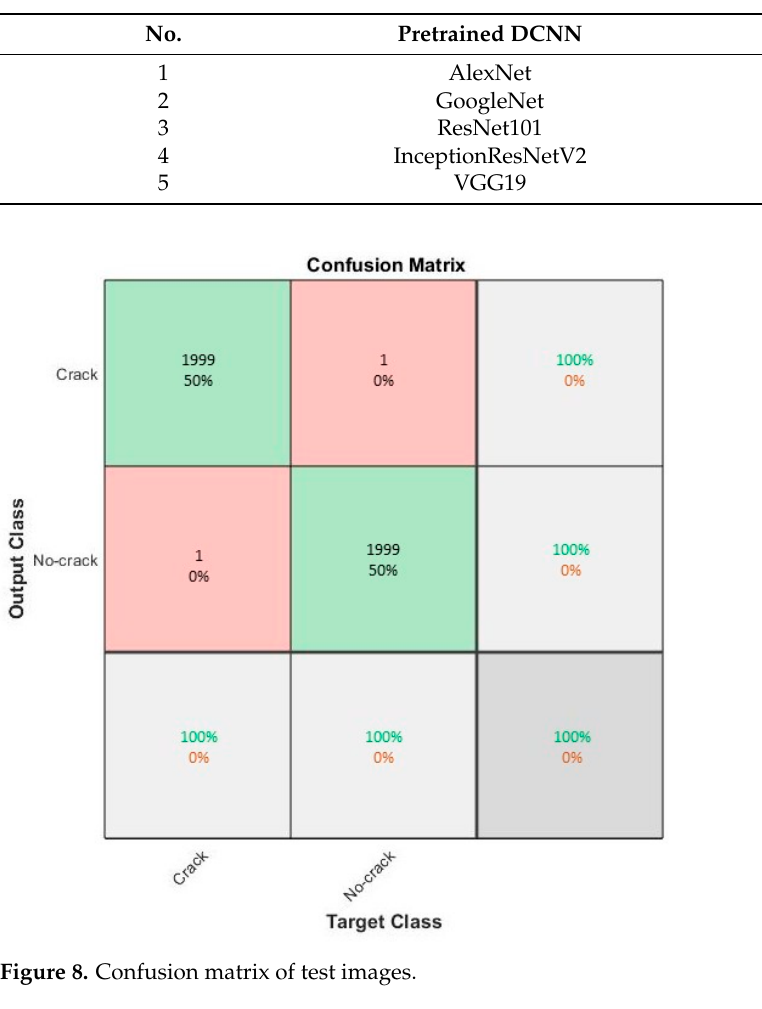
Table 7. Accuracies of pretrained DCNNs.